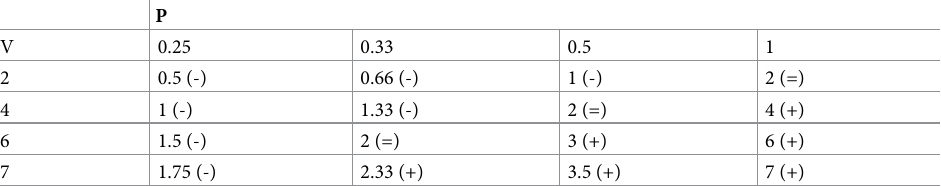
1.75 (-) 2.33 (+) 3.5 (+) 7